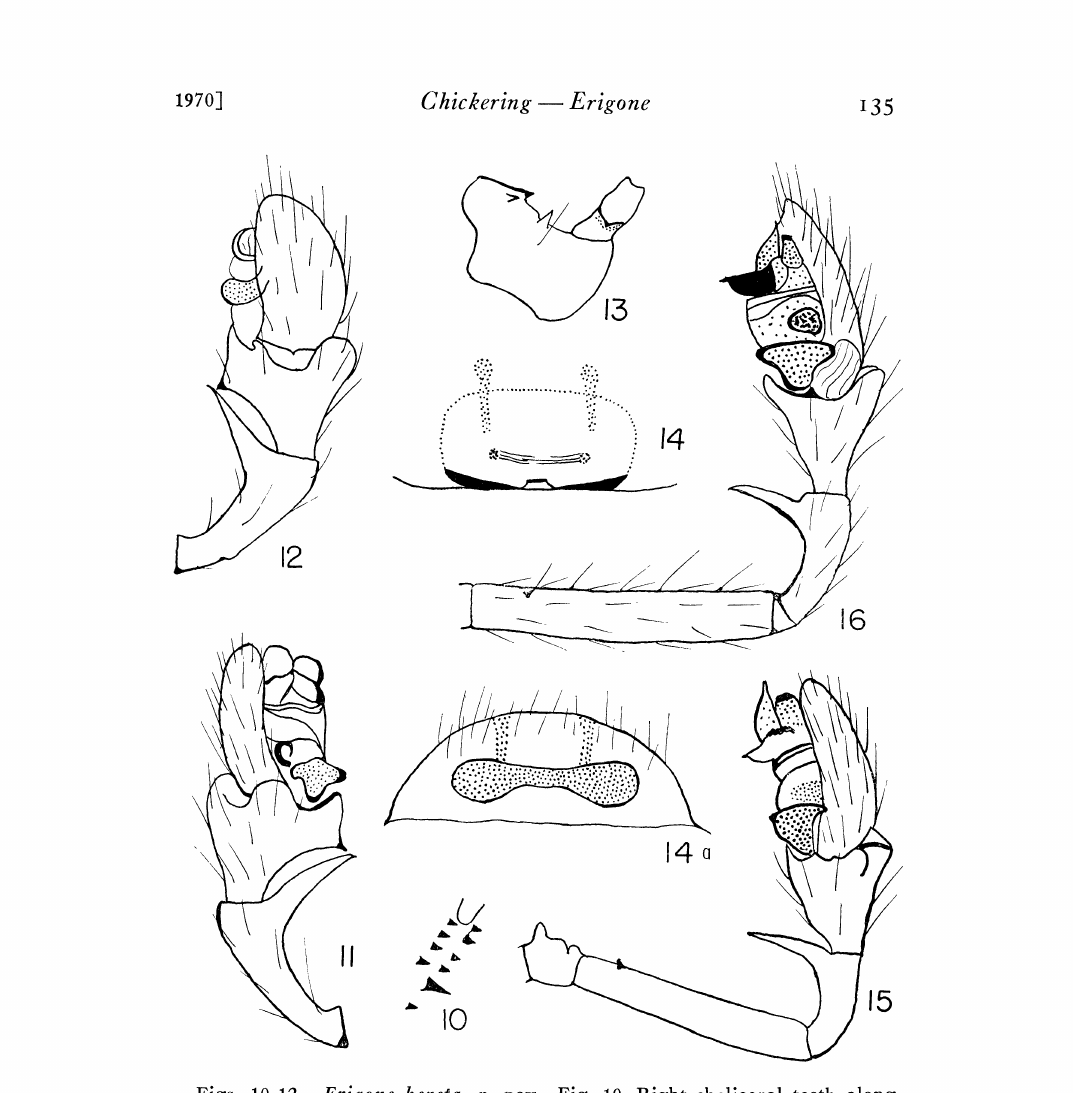
Figs. 10-12. Erigone bereta sp. nov. Fig. 10. Right cheliceral teeth along fang groove. Fig. 11. Right palp of holotype; retrolater,al view. Fig. 12. Idem; dorso-prolateral view. Figs. 13-16. Erigone autumnalis Emerton. Fig. 13. Left maxilla of male from Panama Canal Zone. Fig. 14. Epigynum of female from Panama; seen from below. Fig. 14a. Idem; from behind with posterior border lifted. Fig. 15. Left palp of male from Trinidad, W. I.; retrolateral view. Fig. 16. Left palp of male from Pu,erto Rico; retrolateral